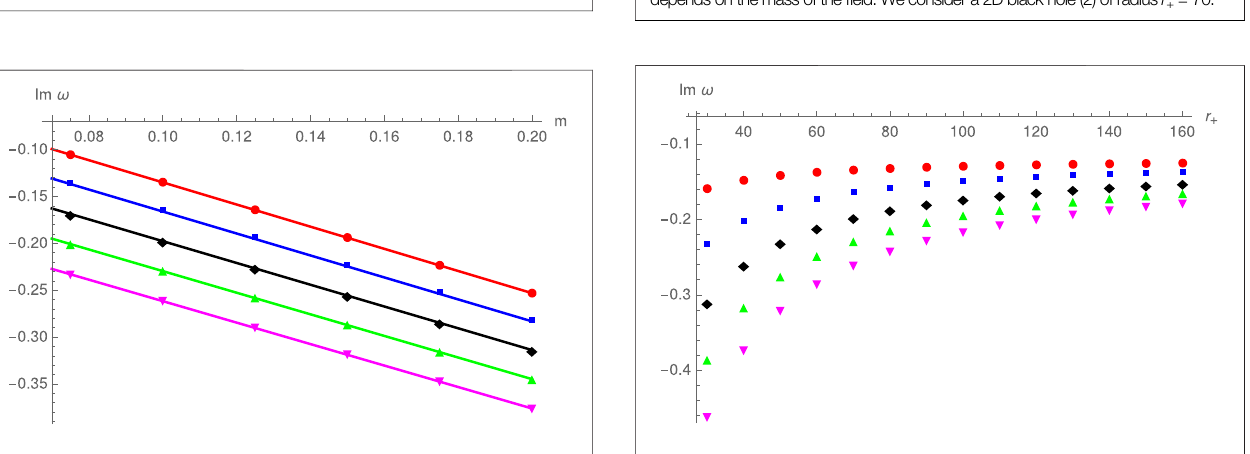
FIGURE 7 | For the fi rst five QNFs of the Dirac fi eld we show how the imaginary part depends on the mass of the fi eld. We consider a 2D black hole (2) of radius r + (cid:1) 70.